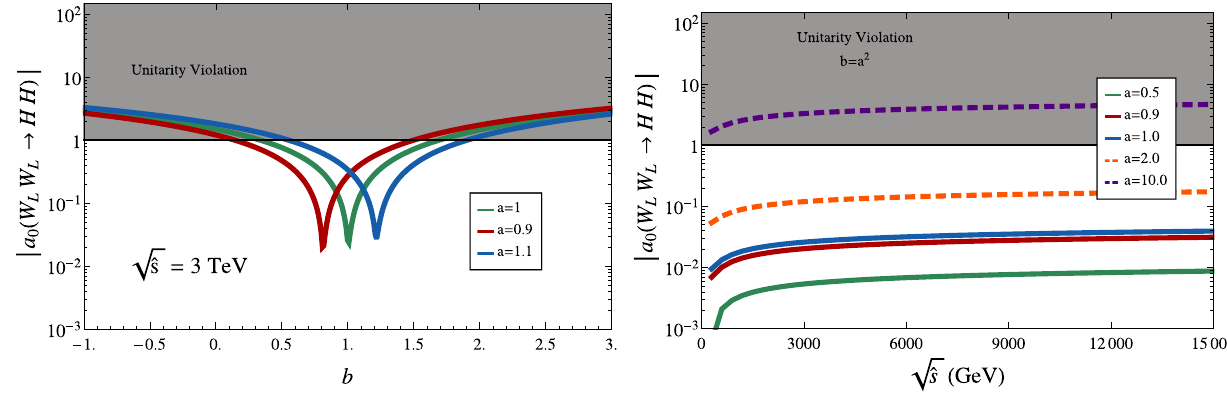
Fig. 10 Lowest partial wave amplitude for W L W L → H H within the EChL. Left panel shows the dependance on the b parameter, for different √ ˆ s = 3 TeV. Right panel shows the dependance on the energy for several values of a , with b determined by the values of a and a fixed energy of relation b = a